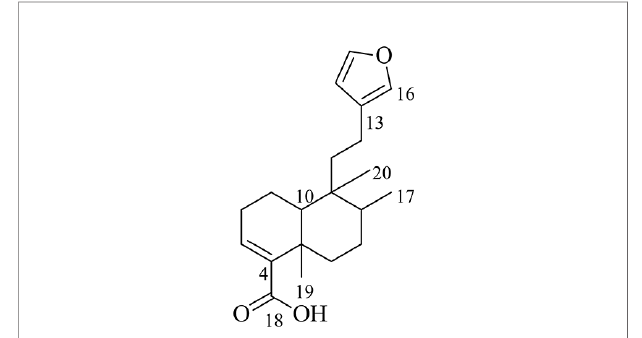
FIGURE 1 | The structure of hardwickiic acid